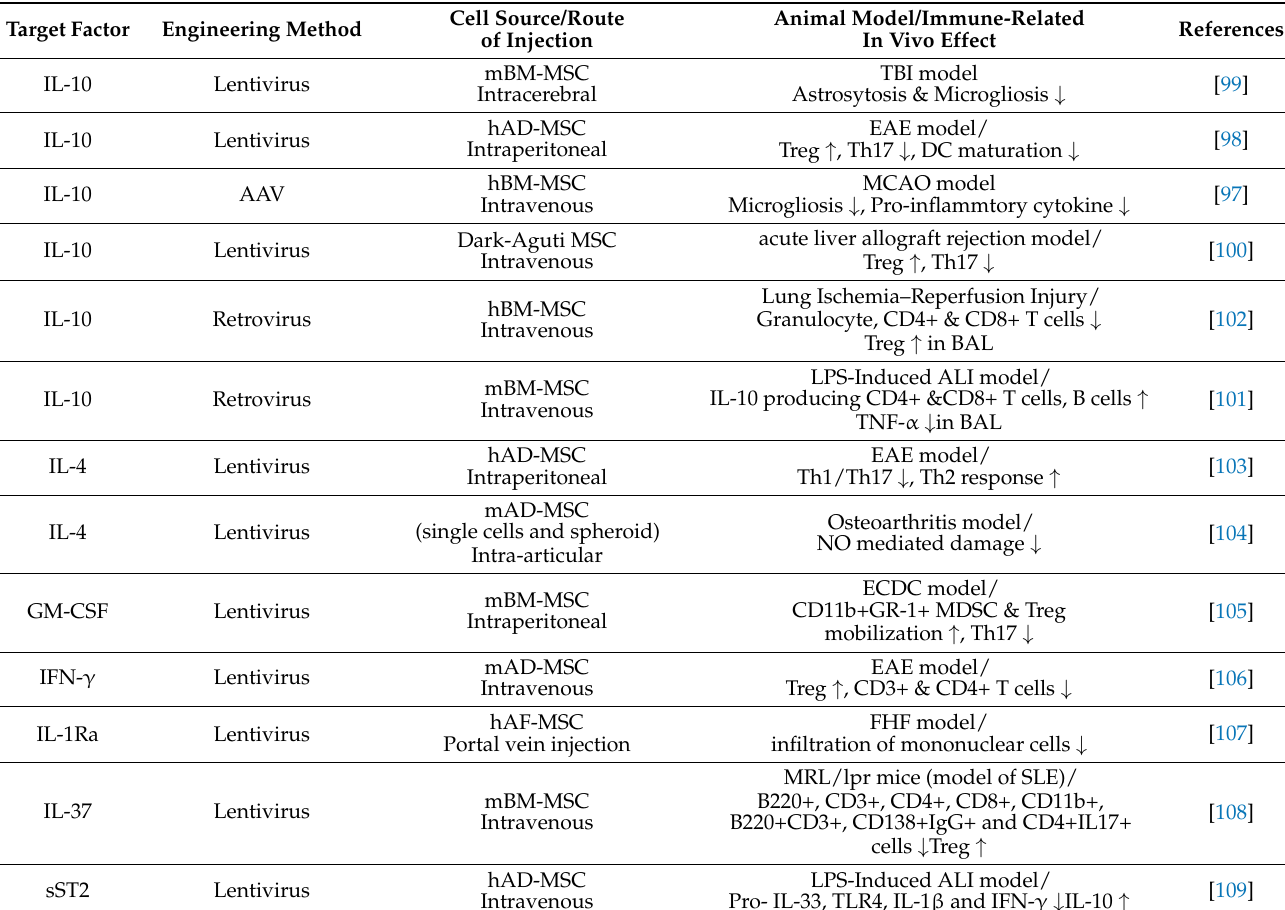
Table 2. The immunomodulatory impact of genetically modified MSCs on animal models. Target